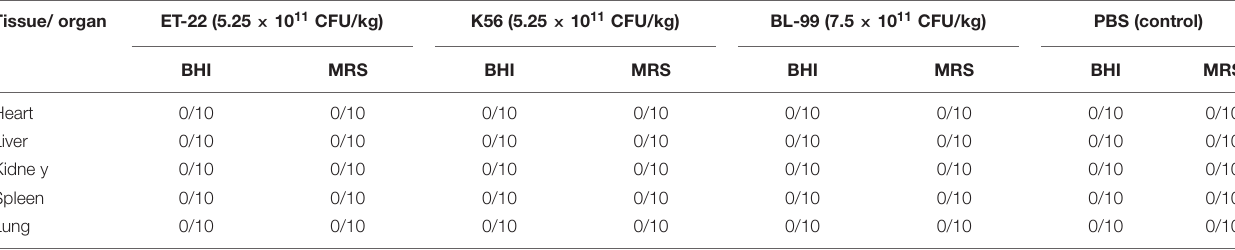
TABLE 6 | The incidence of bacterial translocation in rate from the control and treated groups. Tissue/ organ ET-22 (5.25 × 10 11